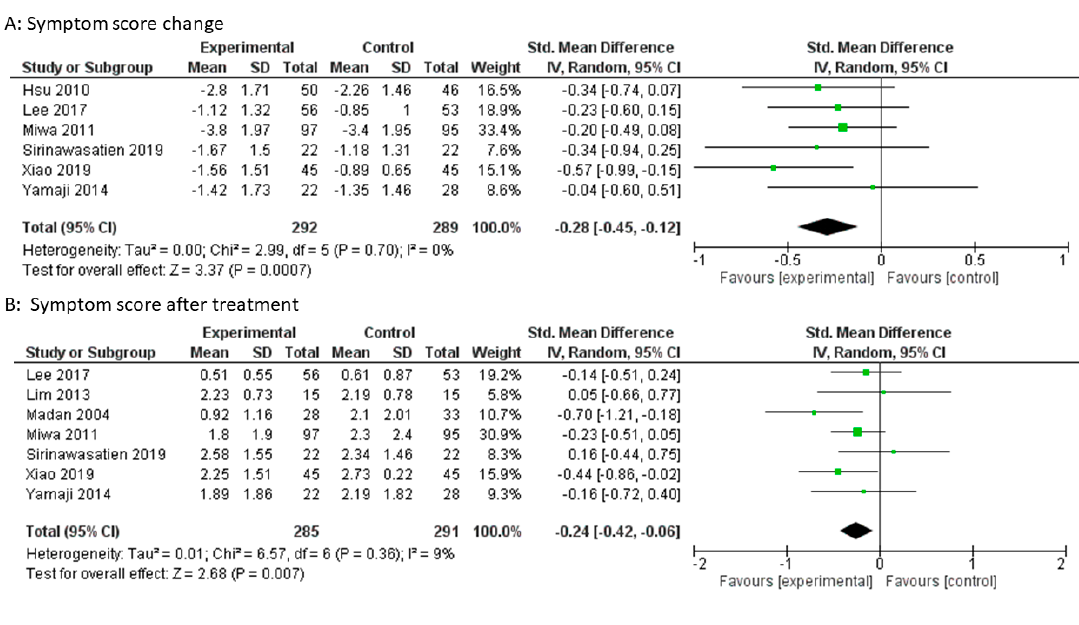
Figure 2. Forest plot of the standardized mean difference (SMD) with 95% confidence intervals (CI) for mosapride combined with PPI versus PPI alone for gastroesophageal reflux disease. ( A ): Symptom score change. ( B ): Symptom score after treatment.